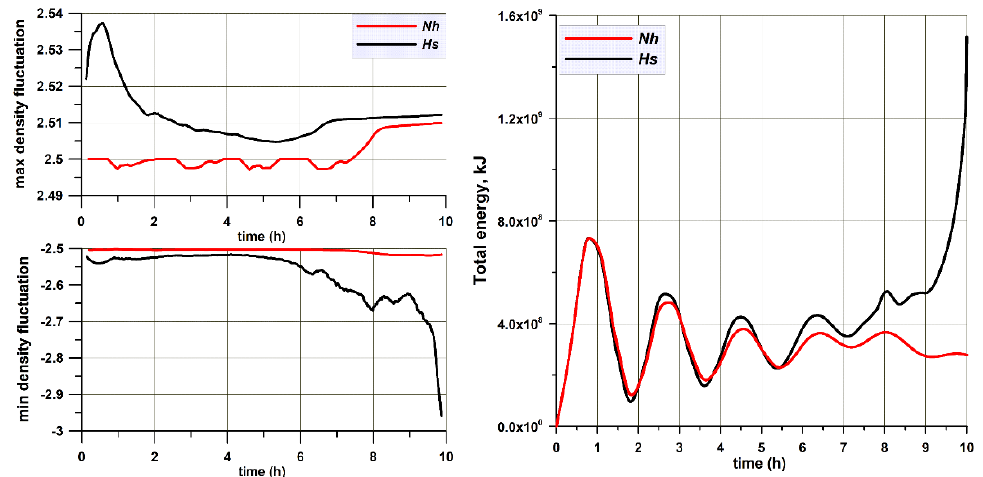
Figure A3. Vertical velocity distribution (m/s) for hydrostatic approach (left) and nonhydrostatic (right) at time = 10 h.